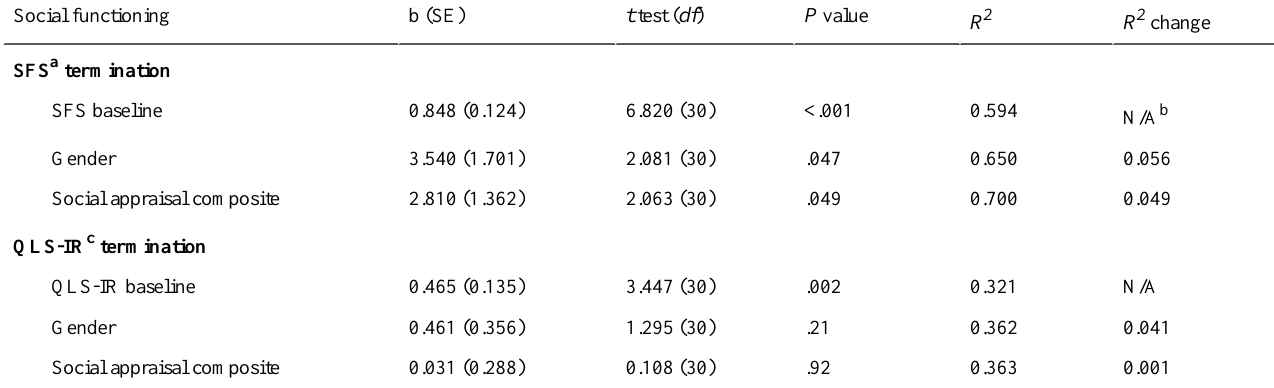
Table 4. Changes in social functioning (Social Functioning Scale and Quality of Life Scale–Interpersonal Relations) from baseline to treatment termination as predicted by ecological momentary assessment-reported social